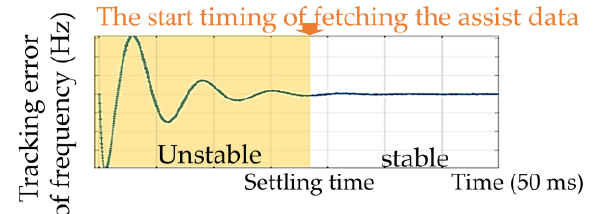
Figure 10. Timing for fetching data from the primary loop.